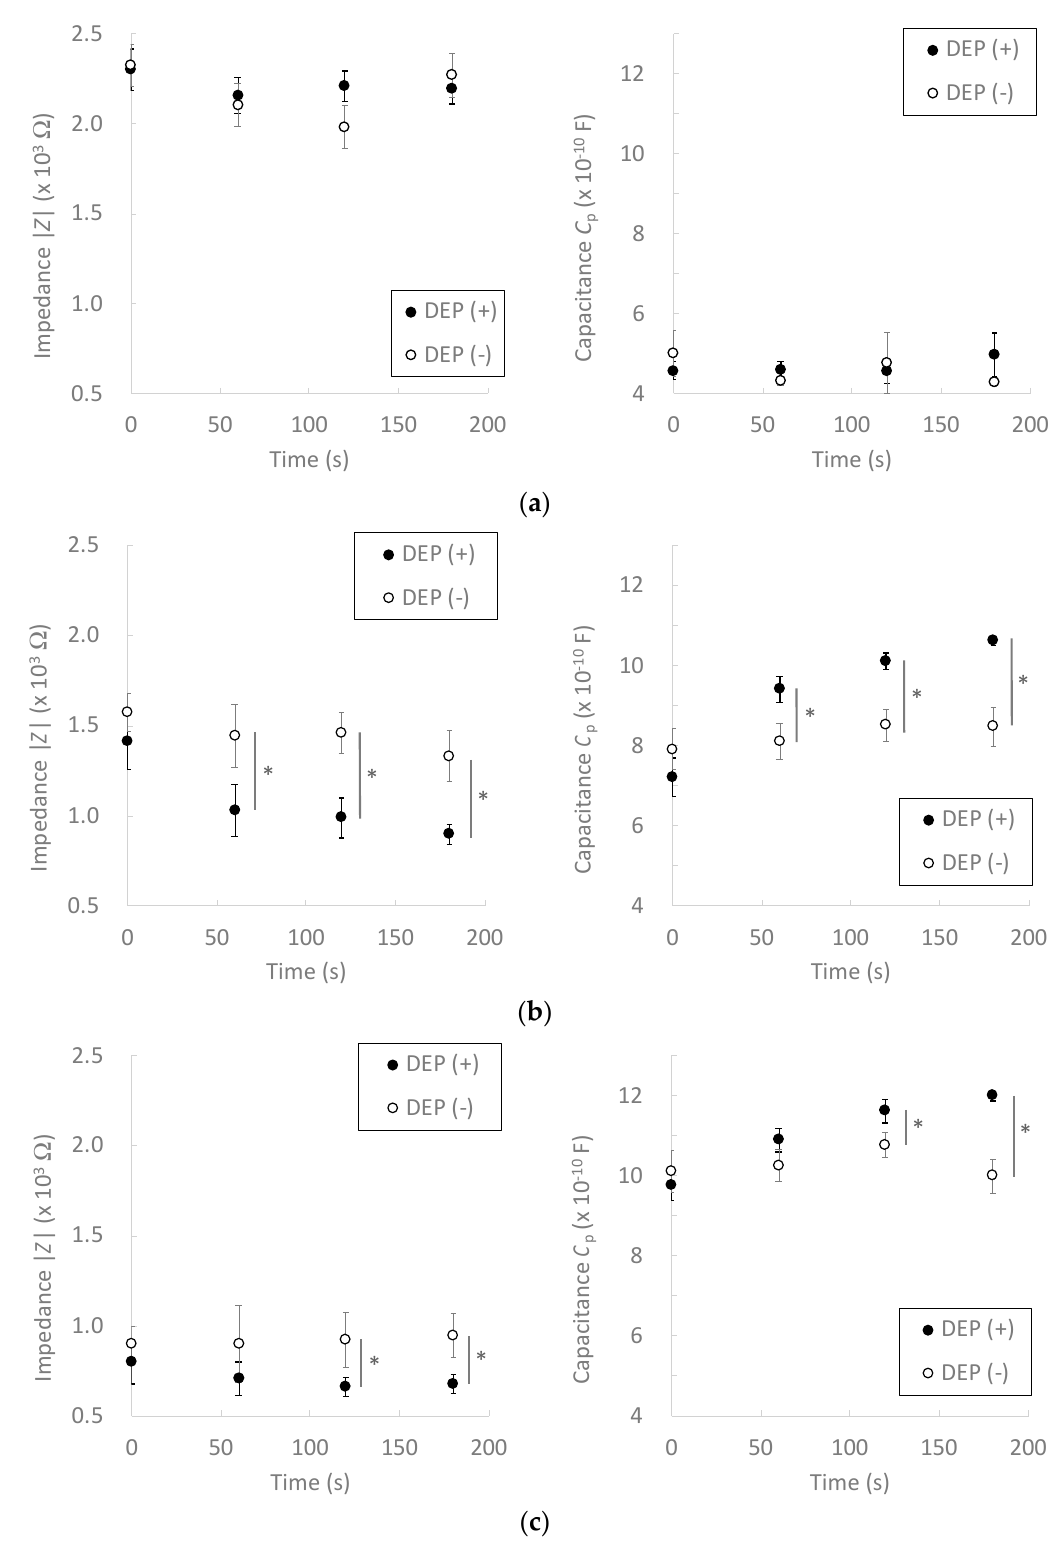
Figure 5. Formation of pearl-chain-like cell aggregates by positive DEP. Phase-contrast images of chondrocytes ( a ) before and ( b ) after positive DEP for 180 s. Scale bar = 100 μ m.